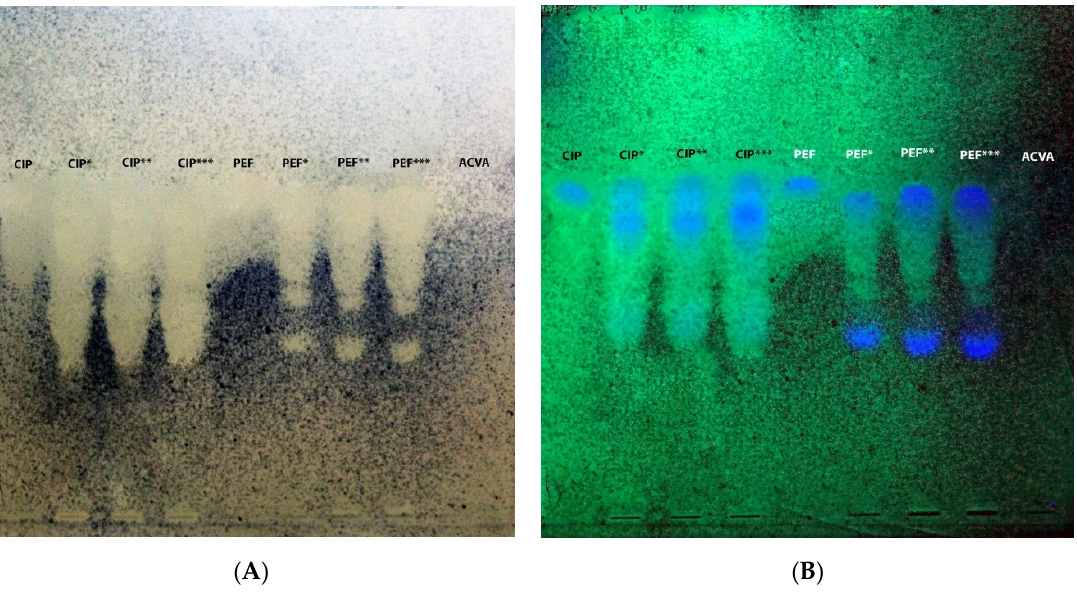
Figure 12. TLC plate sprayed with 0.2% MTT: ( A ) VIS light; white zones are an area of E. coli growth inhibition; ( B ) UV light 254 nm; the blue spots represent the exact places where substances were located. Track 1—standard solution of CIP, tracks 2–4—CIP sample after oxidation with ACVA, track 5—standard solution of PEF, tracks 6–8—PEF sample after oxidation with ACVA and track 9—ACVA solution after incubation at 60 ◦ C for 60